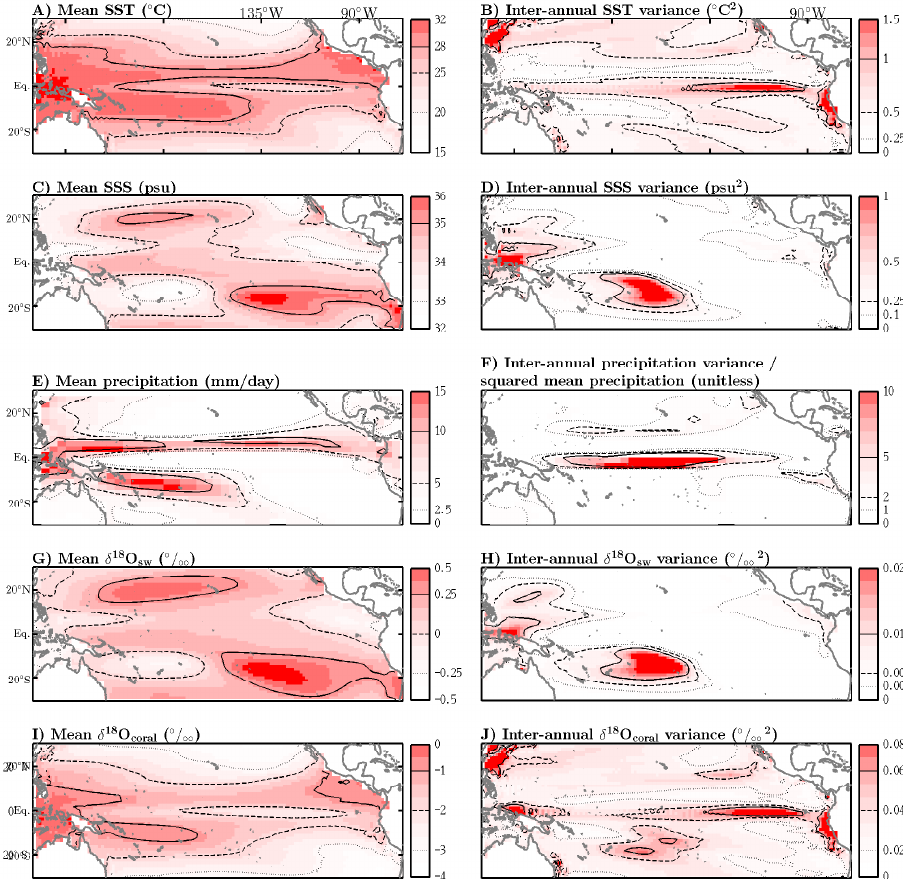
Fig. 1. The mean climatology (left hand panels) and inter-annual variance (right hand panels) of selected model fields over the entire 750 yr control simulation, displayed for the tropical Pacific domain. The entire simulation was used as the reference period for the removal of the annual climatology prior to the variance calculations. Note that the precipitation variability (F) is presented as a dimensionless ratio of the inter-annual variance of precipitation divided by the squared mean values. The contoured levels are highlighted on the colorbars.